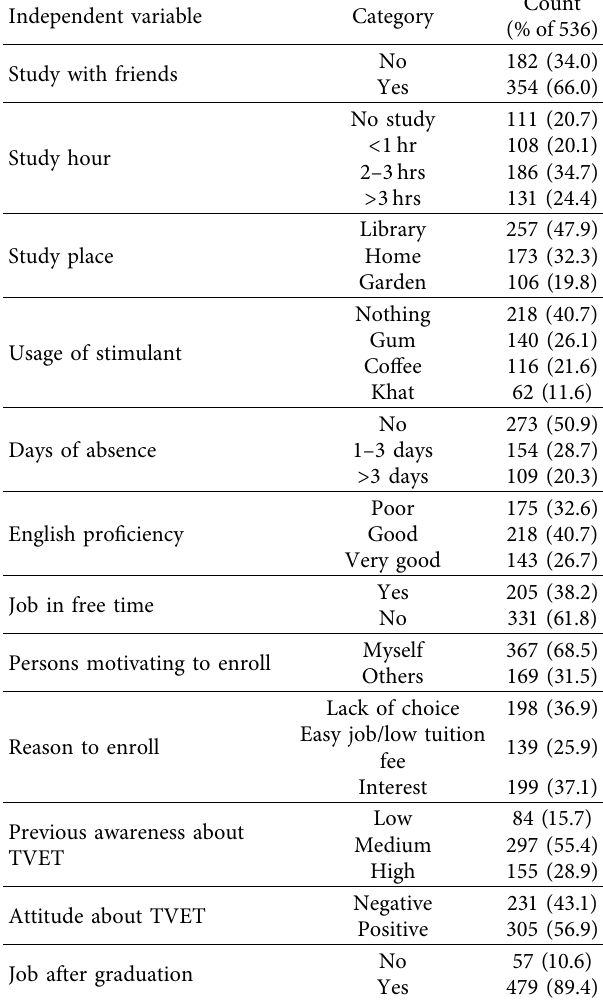
Table 3: Frequency distribution of academic variables. Table 4: Descriptive statistics of students’ overall satisfaction